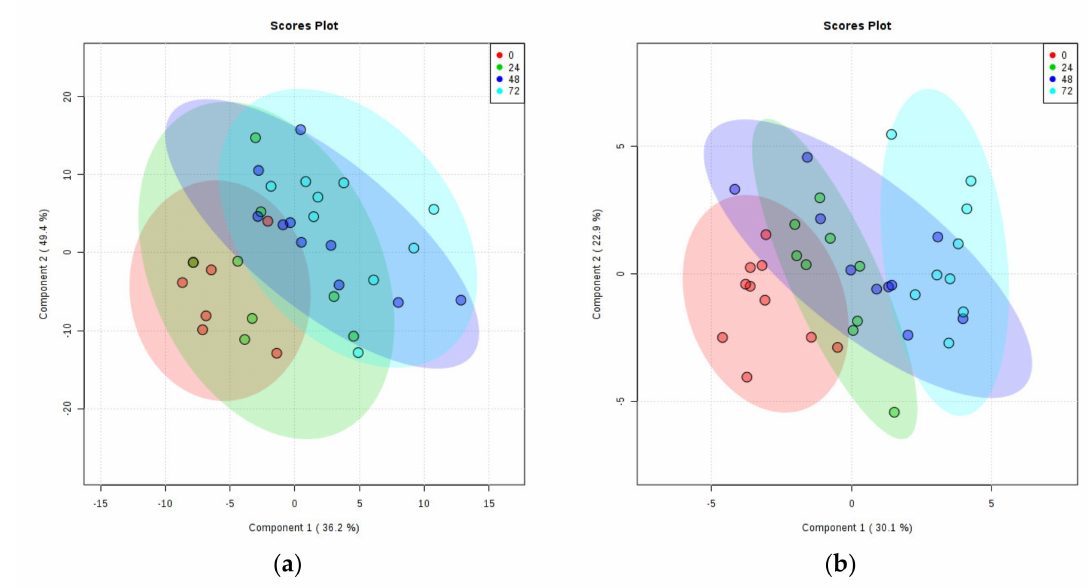
Figure 3. PLS-DA Plots of Rat Brain Tissue Metabolites. ( a ) Rat cortex. ( b ) Rat cerebellum. Ratios of identified metabolites in comparison to selected internal standards within rat brain tissues at 0-h PMD (red), 24 h PMD (green), 48 h PMD (blue), and 72 h PMD (purple). A shows cortex; B shows cerebellum. See Supplementary Materials E for labelled and unlabelled PCA and PLS-DA